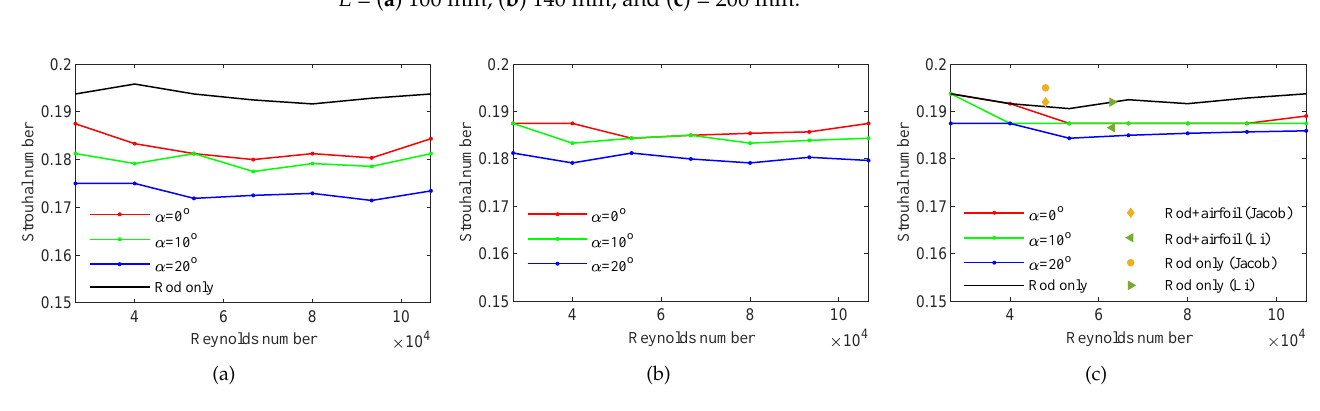
Figure 5. Strouhal number corresponding to the main peak at different airfoil attack angles: L = ( a ) 100 mm, ( b ) 140 mm, and ( c ) 200